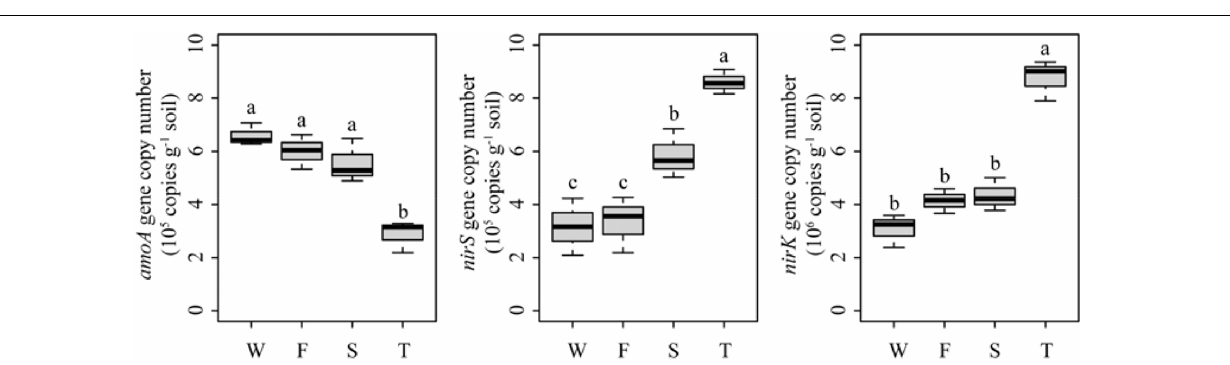
FIGURE 7 | Abundances of amoA , nirS , and nirK genes in the wheat field (W), the first (F), second (S), and third (T) cropping of Jerusalem artichoke (JA) as determined by quantitative PCR. Different letters indicate significant difference based on Tukey’s HSD test ( P <